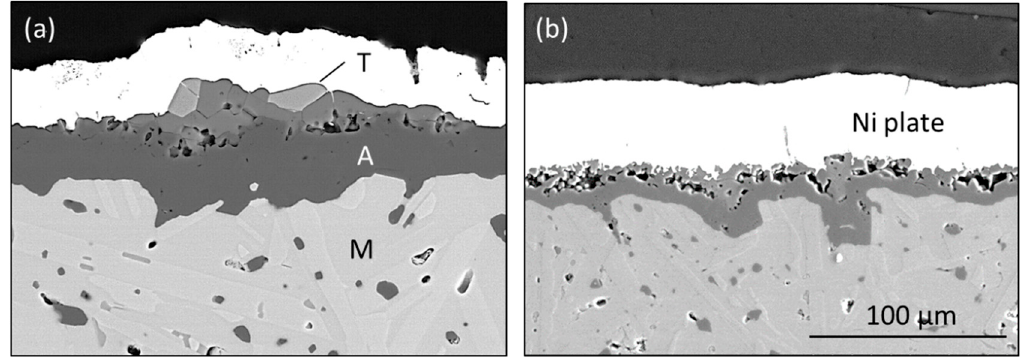
Figure 6. SEM / BSE cross sections of scale microstructures formed on Ti 2 AlC at 1300 ◦ C in ( a ) furnace TGA (100 h) [11] and ( b ) high pressure burner rig (50 h at 6 atm, 25 m / s). Ni (plating); T (Ti-rich transient scale); A (Al 2 O 3 ); M (MAX phase substrate).